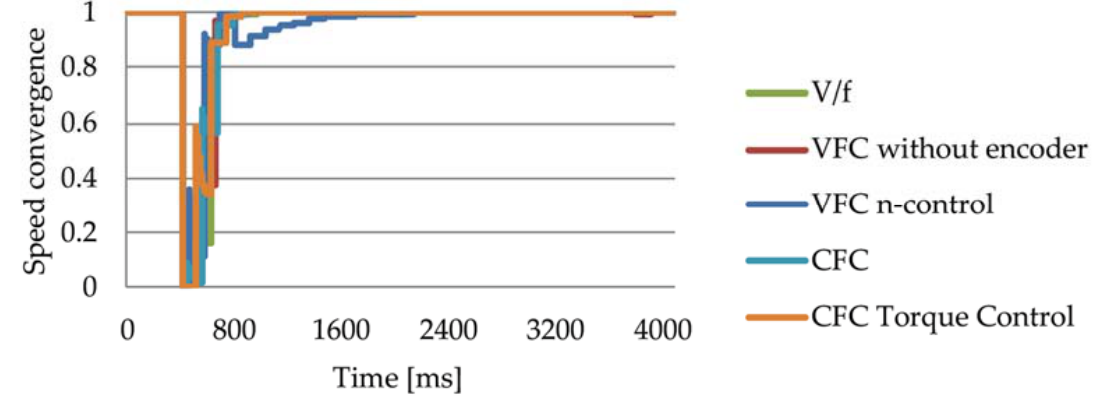
Figure 5 illustrates the S C values for the investigated drive control modes in the unloaded condition.